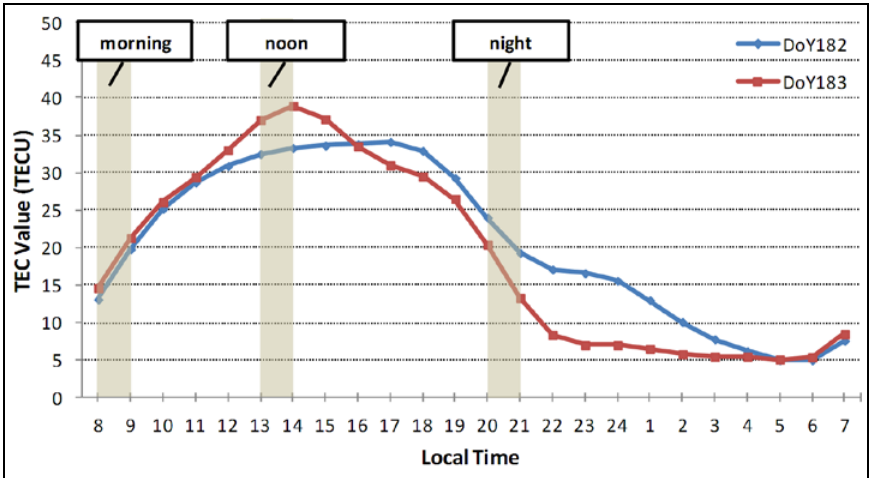
Figure 3. Percentage of ambiguity resolution for DoY 182 and 183